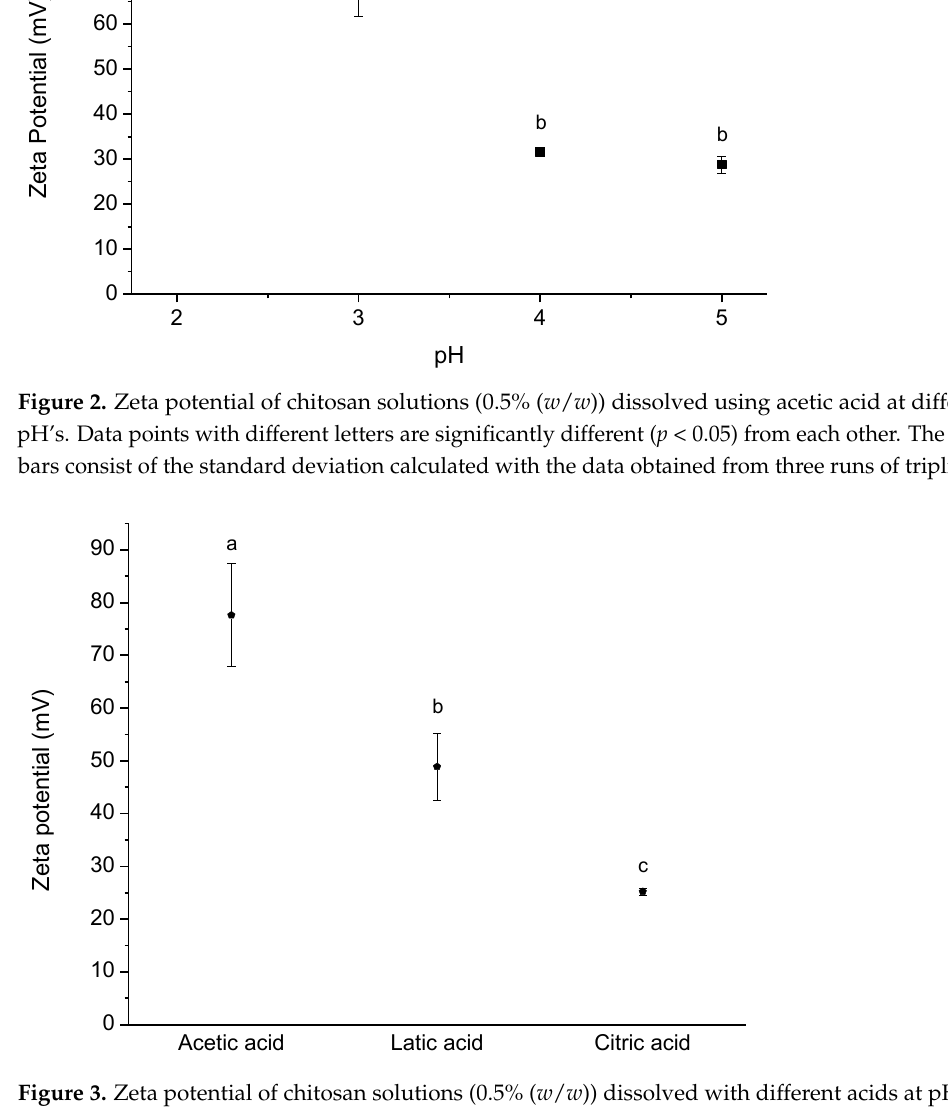
Figure 3. Zeta potential of chitosan solutions (0.5% ( w / w )) dissolved with different acids at pH = 2. Data points with different letters are significantly different ( p < 0.05) from each other. The error bars consist of the standard deviation calculated with the data obtained from three runs of tripli- cate.